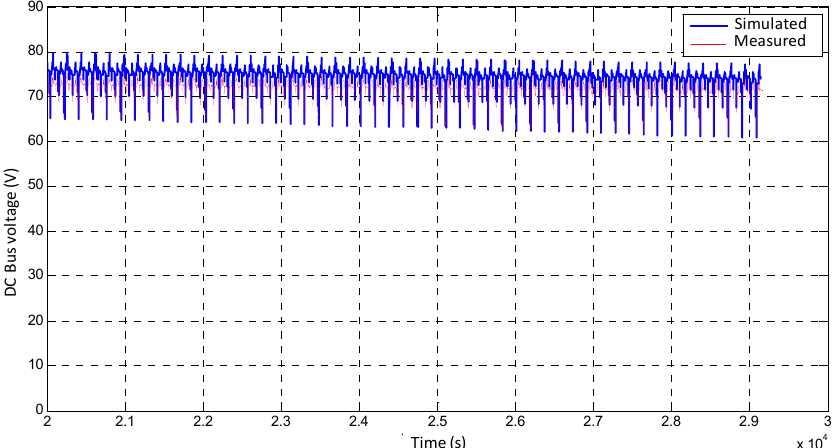
Figure 35. A detail of the last 150 min of both the measured and simulated DC bus voltage along an 8 h working day.